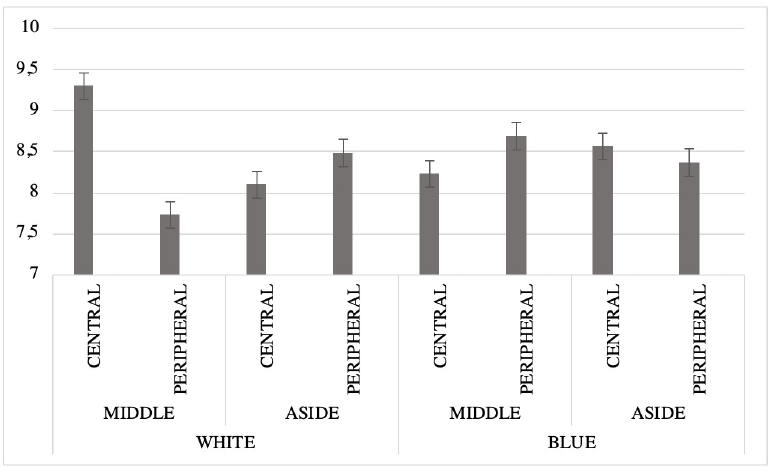
Fig 2. Results of ANOVA performed on status, location and background, regarding effects on certainty of attitudes.